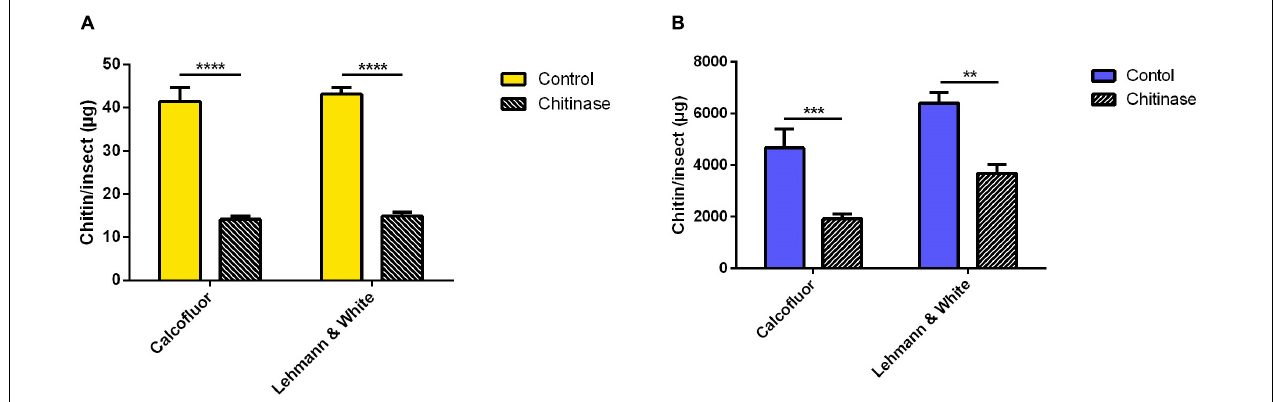
FIGURE 5 | Chitin content assessment in Rhodnius prolixus treated with 1 mg/mL chitinase from Streptomyces griseus , comparing measurement methods by Lehmann and White (1975) and calcofluor fluorescent brightener. (A) First instar nymphs pooled in groups of 10 in 200 µ L distilled water (B) Adults homogenized individually in 1 mL distilled water. Bars are means of 20 or 10 biological replicates for nymphs or adults, respectively, with the standard error of the mean (SEM). Asterisks denote statistically significant differences, ** p ≤ 0.01, *** p ≤ 0.001, and **** p ≤ 0.0001. TABLE 2 | Chitin amounts per insect in three different species, as measured by with Lehmann and White and Calcofluor white staining techniques. Lehmann and White microplate procedure Calcofluor white staining Before chitinase After chitinase Before chitinase After chitinase treatment ( µ g) treatment ( µ g) treatment ( µ g) treatment ( µ